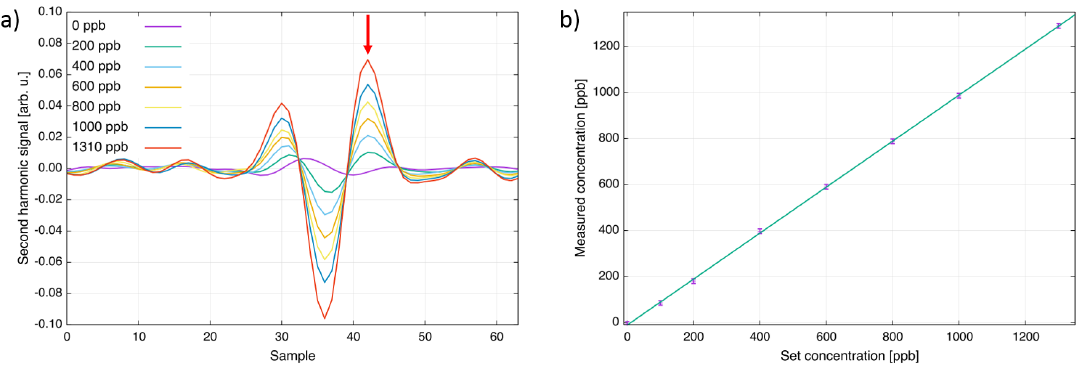
Figure 2. ( a ) Second harmonic spectra of CF 4 for different concentration levels at T = 125 ◦ C. The peak indicated by an arrow was used for the concentration calculation; ( b ) Comparison of the concentration set at the gas mixer and the value measured with the QCL CF 4 sensor.